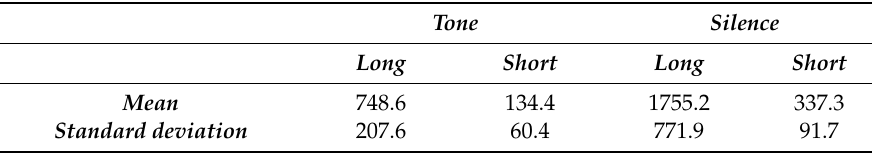
Table 3. Statistical analysis of Morse codes typing (ms).